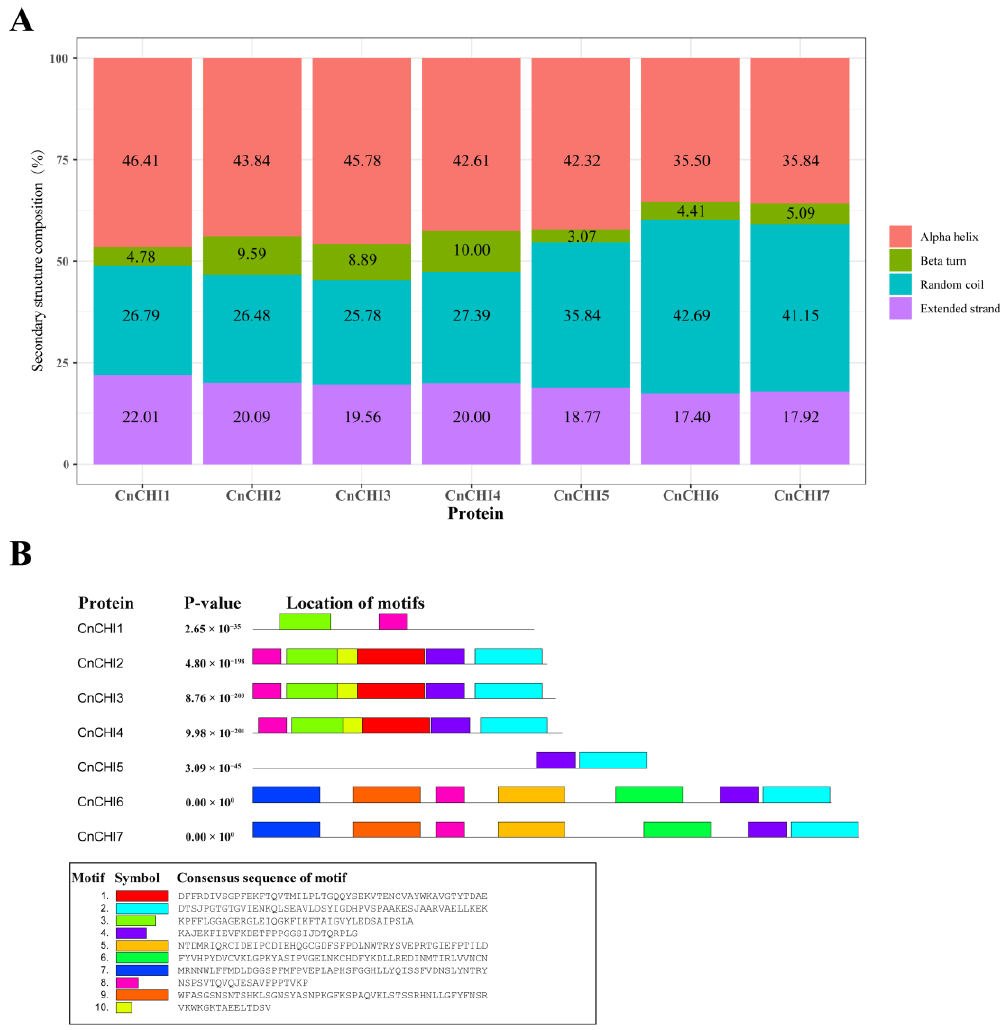
Figure 1. Characteristics of CnCHI protein sequences. ( A ) Secondary structure composition of CnCHI proteins. ( B ) Distribution of the conserved motifs in CnCHI proteins. A total of 10 motifs were predicted for each protein using the MEME online analysis software.